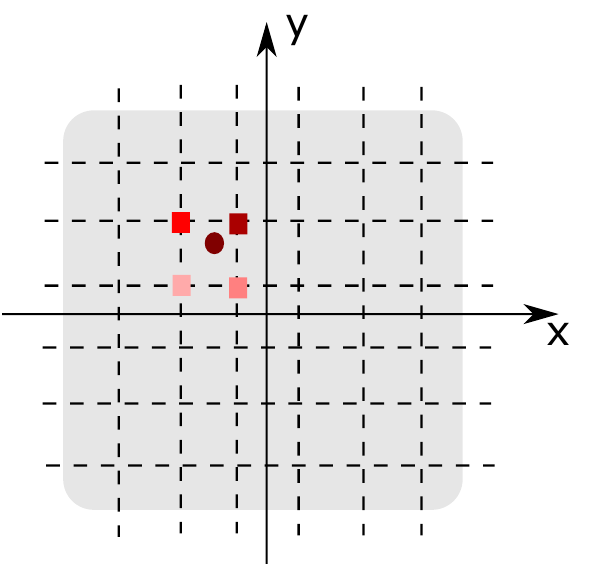
Figure 1. The unknown positions of radiating elements of the Antenna Under Test (AUT) are approximated by a grid of points, obtaining a ”Grid Array“ (GA) whose radiating elements are in the grid positions; the red points represent the position of a source of the AUT; if the position does not coincide with the position of one element of the GA, the AUT element excitation may be approximated in the GA by a cluster of radiating elements (red squares); the effect is an increase in the number of non-null radiating elements of the GA, i.e., of the order of sparsity of the retrieval problem; this causes an increase in the number of measurements required to solve the sparse problem, that is proportional to the number of non-null elements of the